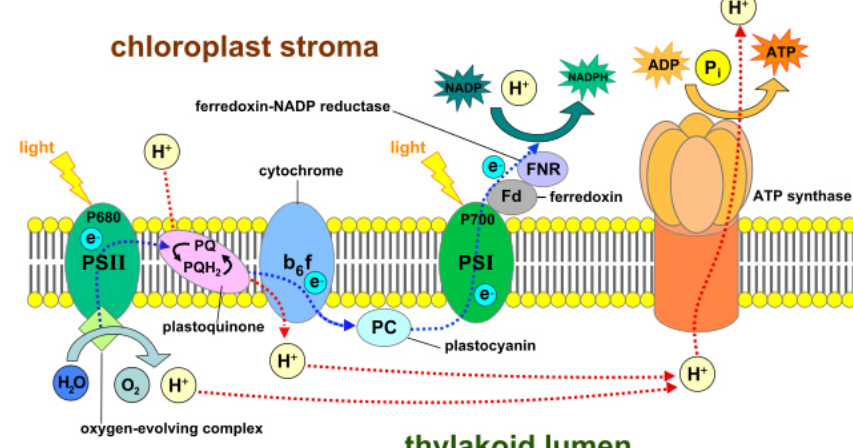
Figure 8. Light-dependent photosynthesis reactions demonstrating the mechanisms of photosystem-I (PSI), the cytochrome b 6 f complex, photosystem-II (PSII), ferredoxin-NADP + reductase (FNR) and ATP synthase. ADP: Adenosine diphosphate; ATP: Adenosine triphosphate; NADP + /NADPH: Nicotinamide adenine dinucleotide